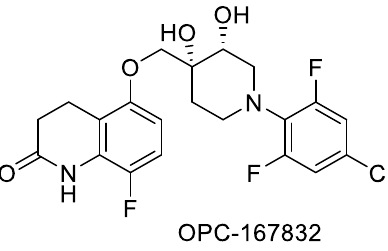
Figure 7. Structure of OPC-167832.